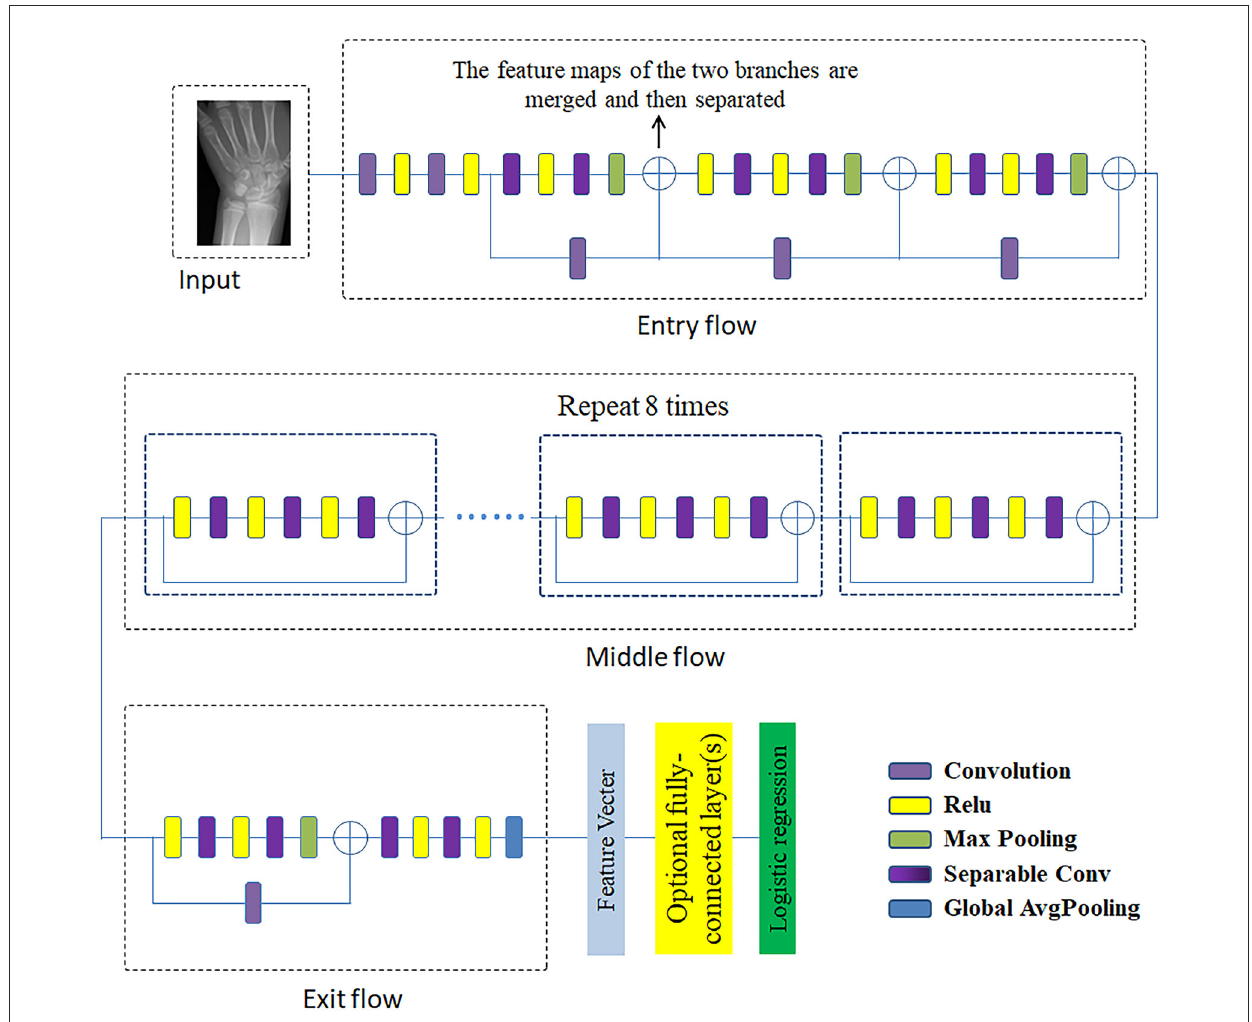
FIGURE7 The architecture of Xception